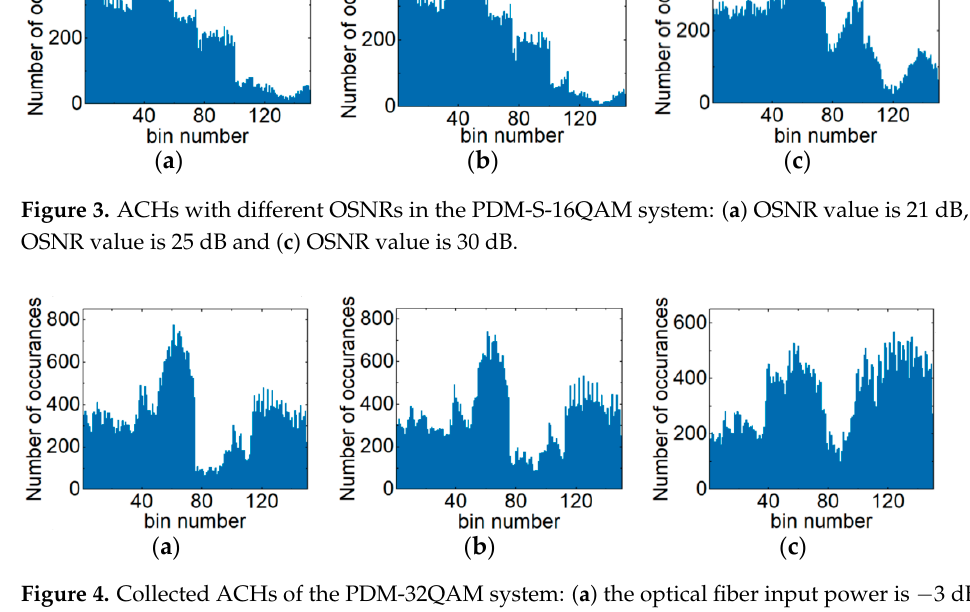
Figure 4. Collected ACHs of the PDM-32QAM system: ( a ) the optical fiber input power is − 3 dBm, ( b ) the optical fiber input power is − 1 dBm and ( c ) the optical fiber input power is 2 dBm.